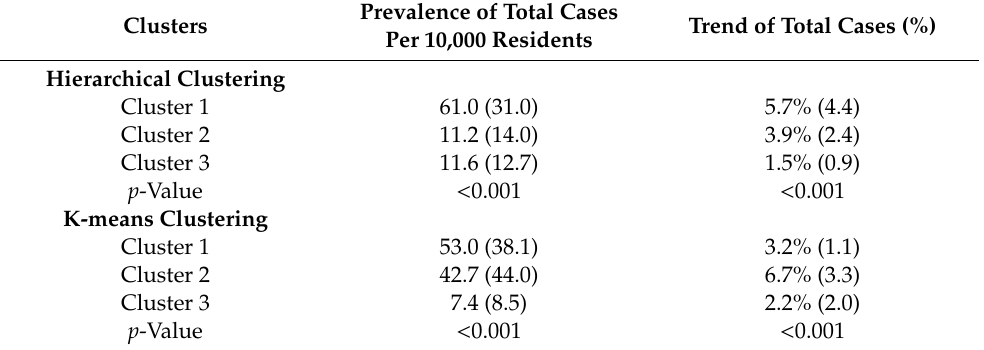
Table 6. Comparisons of the prevalence of SARS-CoV-2 cases and their trend between clusters of provinces.